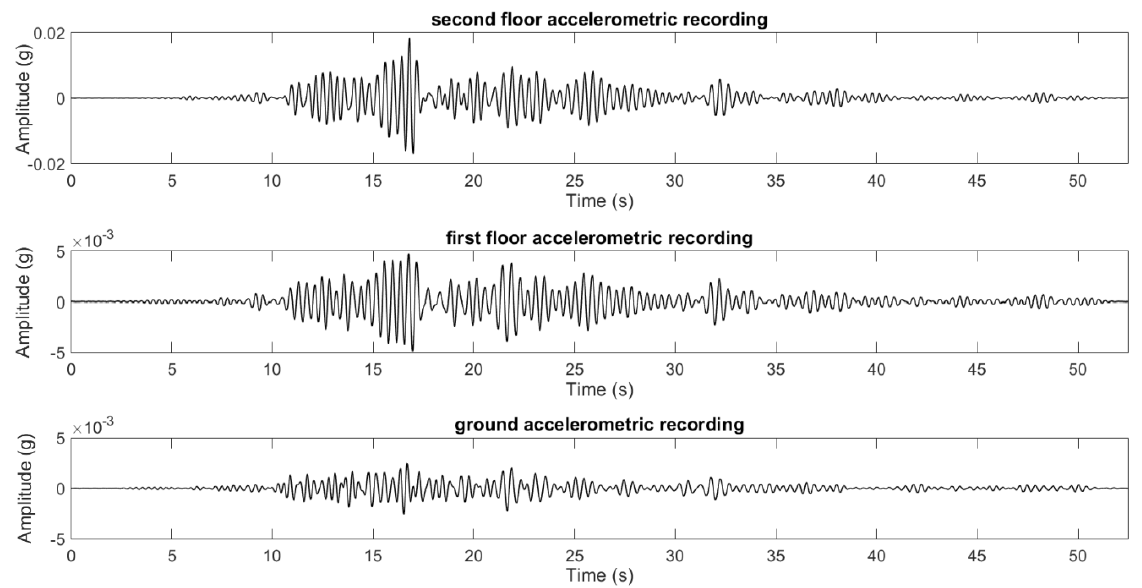
Figure 21. Accelerometric recordings at the different floors of the Navelli municipality building along the transversal direction.